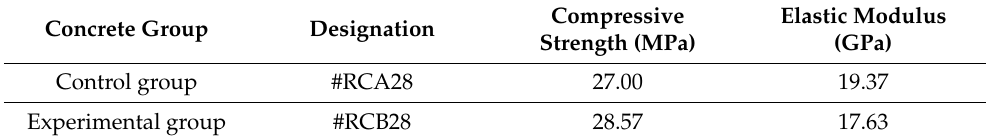
Table 9. Relative-compressive-strength ratio of the compressive failure specimen after self-healing. Concrete Group